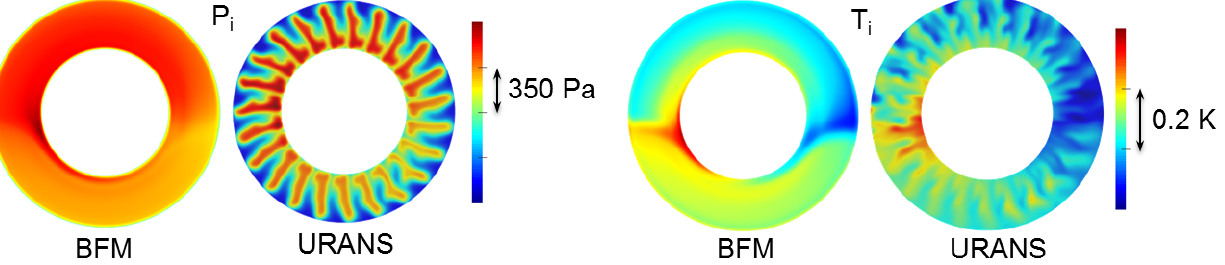
Figure 14. Total pressure ( left ) and total temperature ( right ) downstream of the stator.